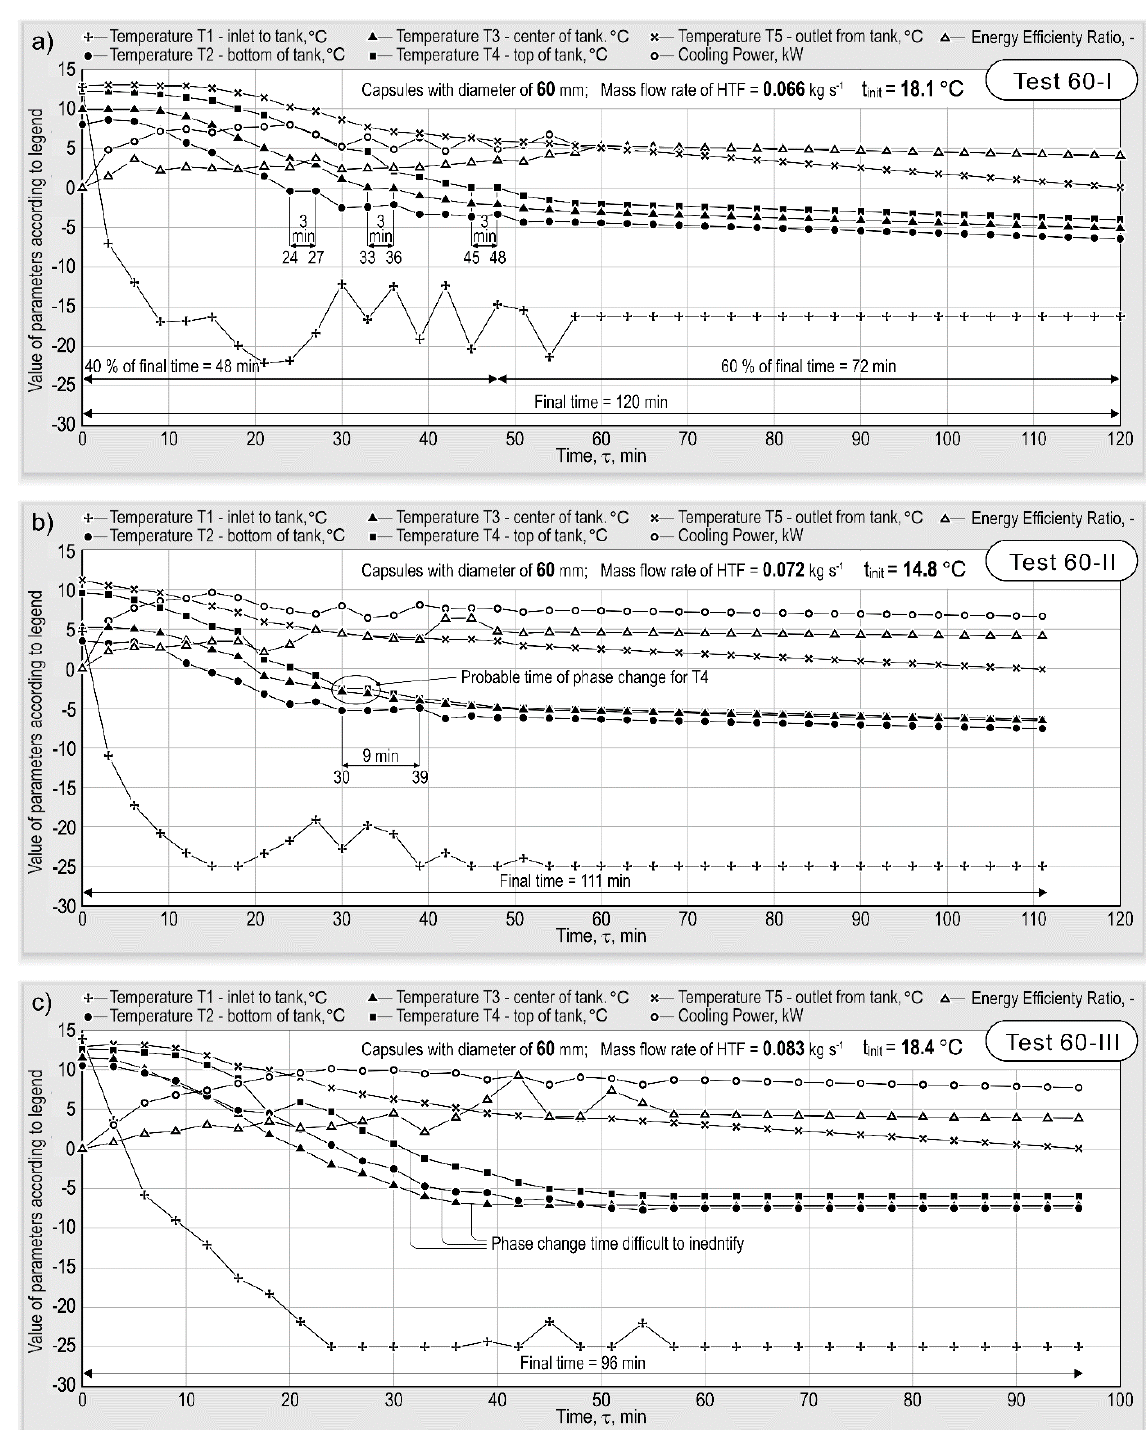
Figure 6. Measurement results: distribution of temperatures, cooling power, and energy efficiency ratio as a function of time for 70-mm-diameter capsules: ( a ) Test 60-I; ( b ) Test 60-II; ( c ) Test 60-III.